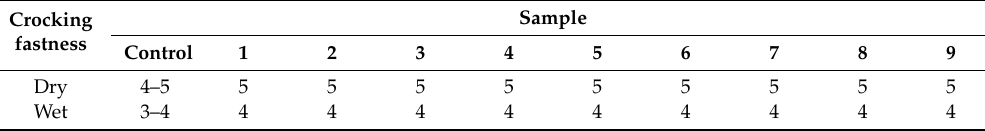
Table 6. Crocking fastness rating of 5g/L pigment-dyed cotton